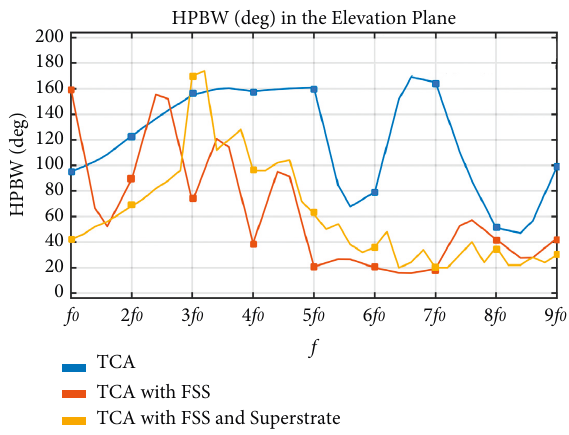
Figure 12: Frequency response of the HPBW in the elevation plane.